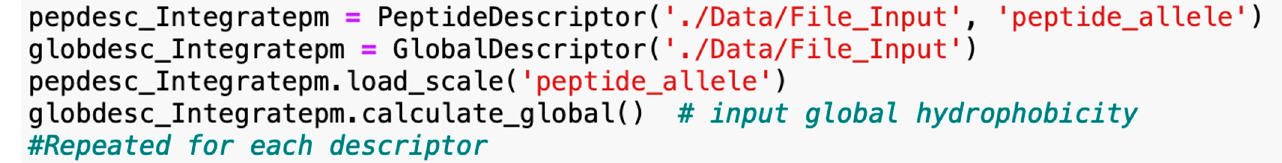
Figure 5. We utilized the input portion from the non-hemolytic peptide model’s descriptor [9]. We aimed to run through a list of peptide allele descriptors specified by the program, which were hydrophobicity values for the original code. The complete code for the referenced methods, as allowed for use by the HemoPI creators’ license, is in the Supplementary Materials (Supplementary File S10).